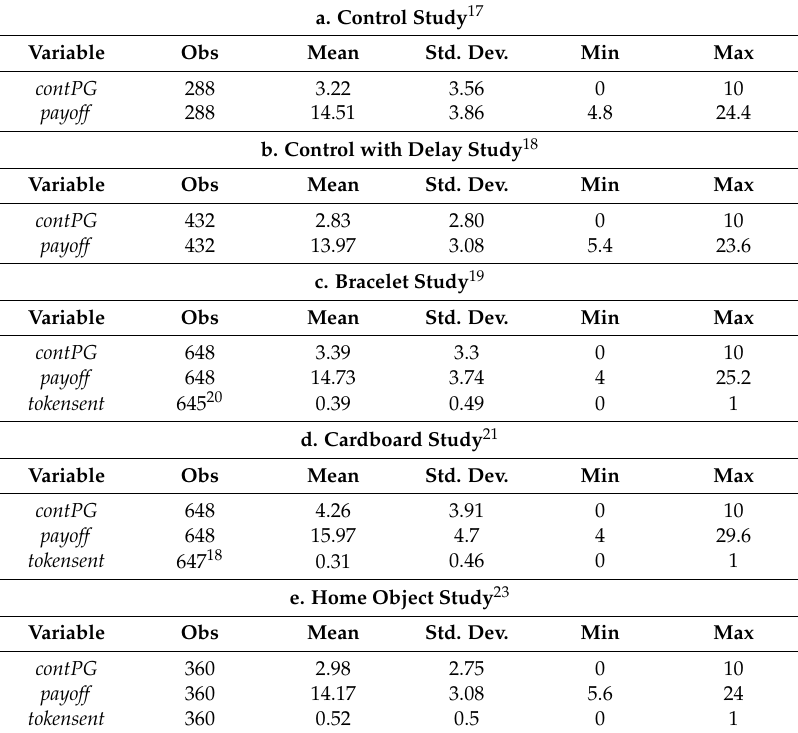
Table 1. Descriptive statistics for each